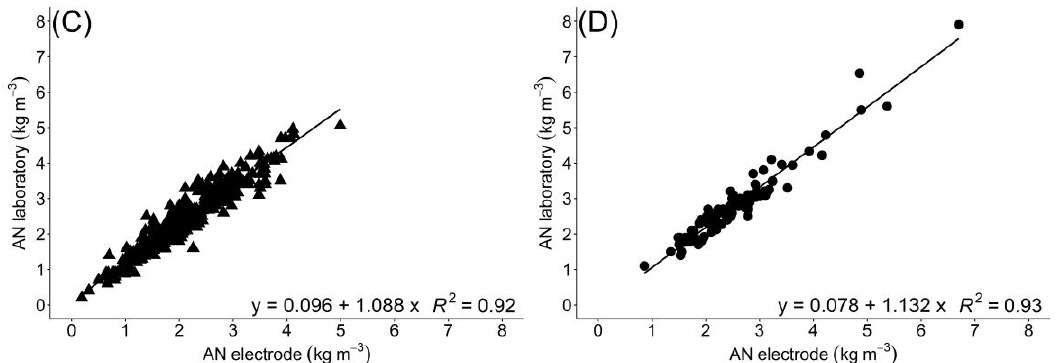
Figure 1. Relationships for the ammonium concentrations measured in the laboratory versus the ammonium concentrations measured with ion-selective electrode of the total sample set (n = 619): ( A ), cattle slurries ( ■ ) (n = 139); ( B ), pig slurries ( ▲ ) (n = 391); ( C ) and digestates ( ● ) (n = 89); ( D ).